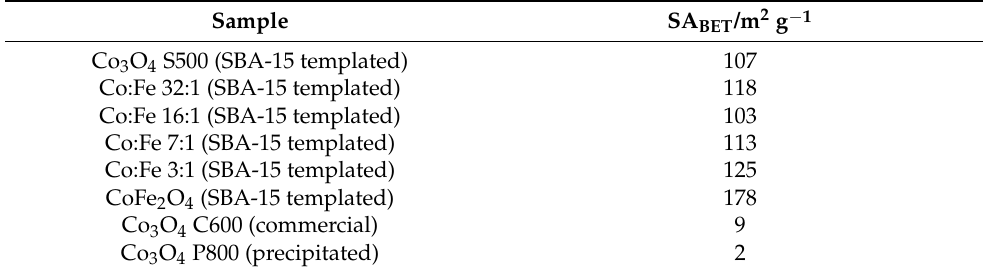
Table 1. BET surface areas of the catalysts used for catalytic